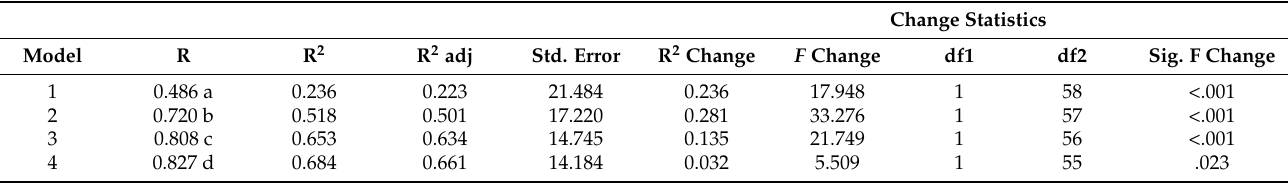
Table A7. Model summary for text fluency at